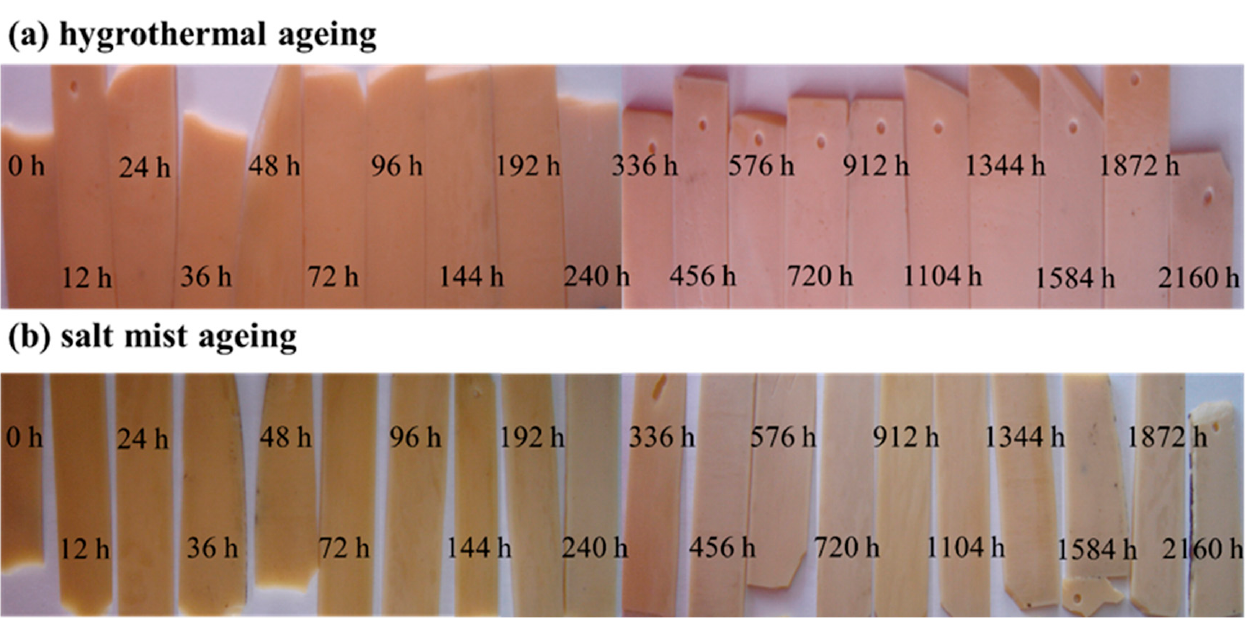
Figure 6. Change in the colour of the epoxy resin casting sheets before and after ageing: ( a ) hygro ‐ thermal ageing; and ( b ) salt mist ageing. The changes in the density of the epoxy resins at different ageing times are shown in Figure 7. Initially, the density of the epoxy resin increased marginally, and then it started to decrease after approximately 36 h.